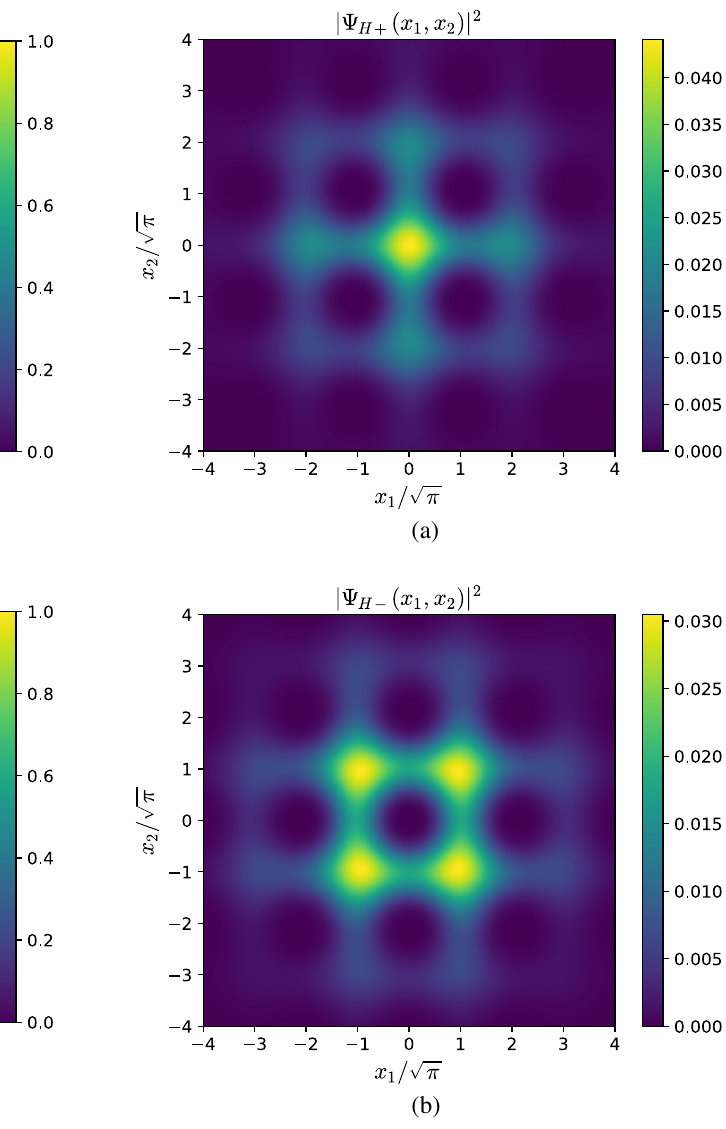
FIG. 8. Absolute values squared of the wave functions FIG. 9. Absolute values squared of the quasidegenerate ground x 1 ; x 2 Þ and (b) Ψ x 1 ; x 2 Þ . These wave functions (a) Ψ x 1 ; x 2 Þ and (b) Ψ x 1 ; x 2 Þ of the state wave functions (a) Ψ H þ ð H − ð H þ ð H − ð approximate the low-energy eigenstates of the two- Hamiltonian in Eq. (28), which includes a parabolic confinement dimensional Hamiltonian in Eq. (21) and are constructed potential. These functions are obtained by combining Eqs. (31) to be even and odd, respectively, under a π = 2 rotation in the and (43) and are even and odd, respectively, under a π = 2 rotation x 1 x 2 plane. Note that the wave functions in the plot are not in the x 1 x 2 plane. The wave functions here are normalized and are x 1 ; x 2 Þj 2 are the Husimi Q normalized. We remark that j Ψ obtained by using Δ ¼ 0 . 25 . H (cid:4) ð quasiprobability functions associated with the eigenstates ψ X Þ [defined in Eq. (41)] of the projected Hamiltonian H (cid:4) ð in Eq.